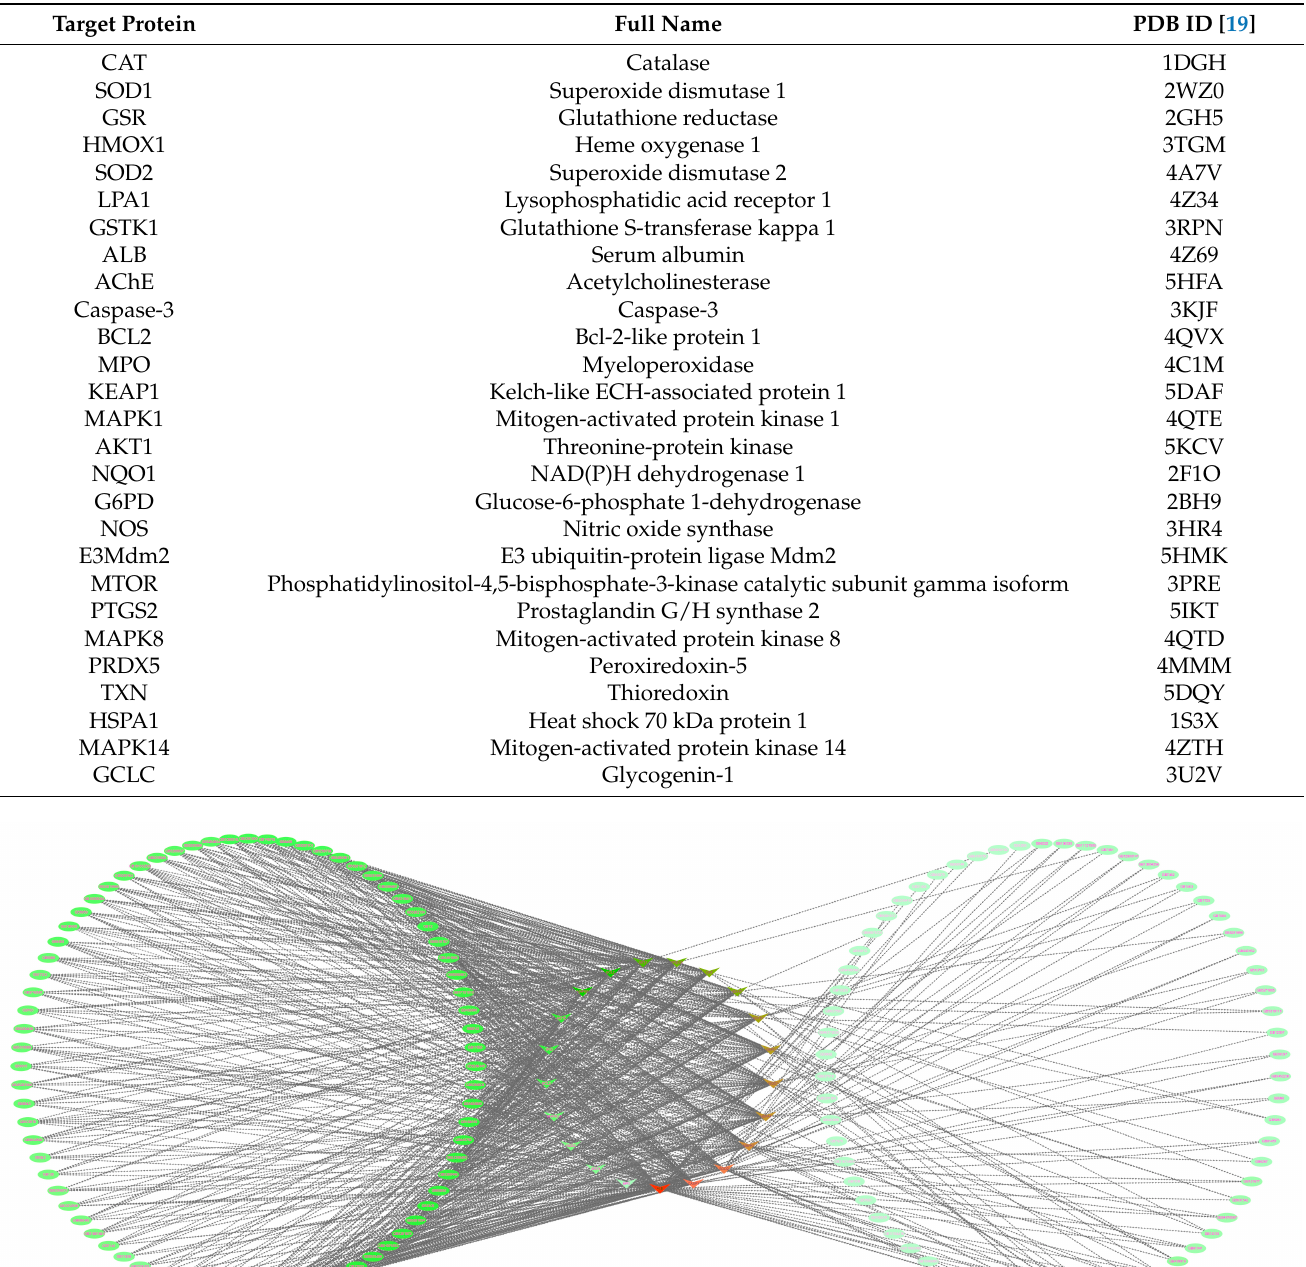
Table 6. Known potential proteins as the antioxidant targets.